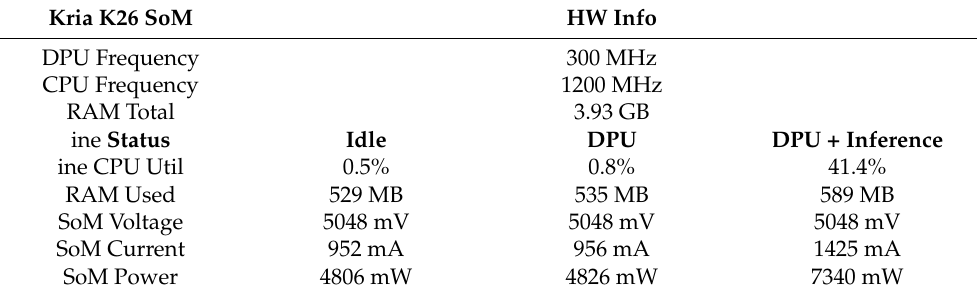
Table 3. Resource utilization on Kria K26 SoM.